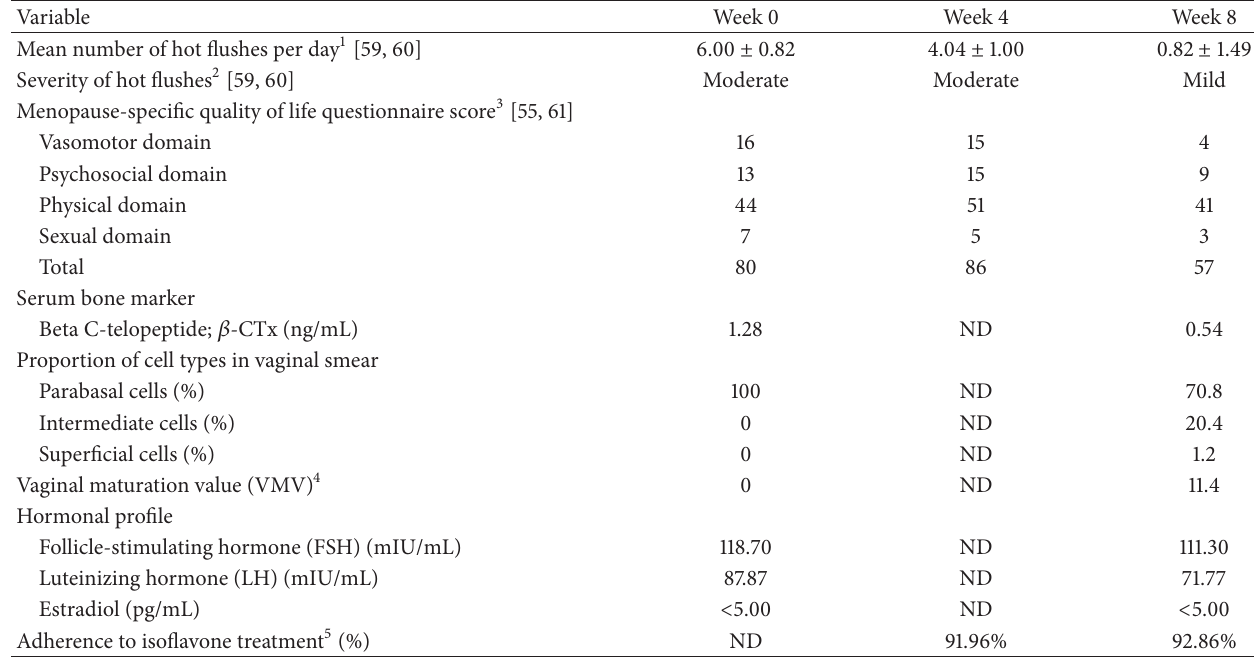
Table 1: Variables measured at weeks 0 (baseline), 4, and